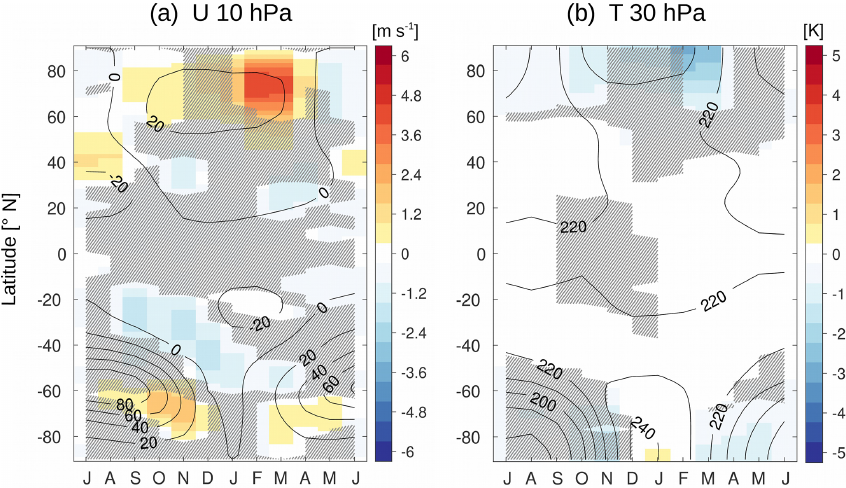
Figure 10. Climatological zonal mean (a) zonal wind at 10hPa in ms − 1 , and (b) temperature at 30hPa in K with month and latitude for Chem OFF CTRL (contours) and for the difference between Chem ON CTRL and Chem OFF CTRL (shading). Contour intervals are (a) 20ms − 1 , and (b) 10K. Statistically insignificant areas are hatched at the 95%